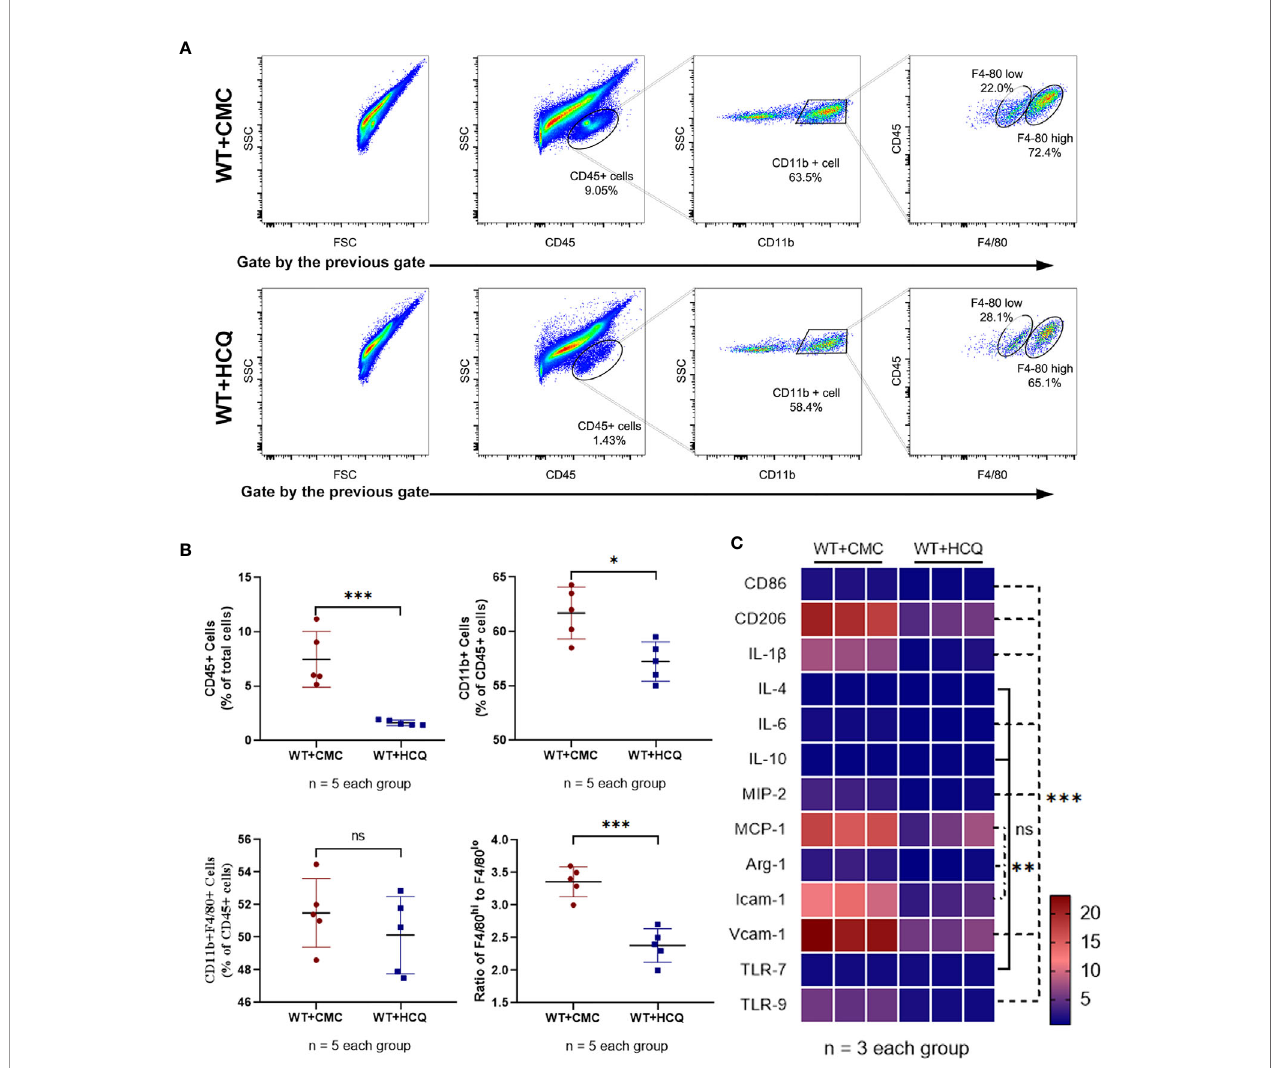
FIGURE 2 | HCQ treatment regulates leukocyte in fi ltration and phenotype of macrophage in the kidney following IRI in vivo . In fl ammatory cell in fi ltration in CMC- treated and HCQ-treated kidneys at day 28 following IRI was determined using fl ow cytometry. (A) Representative dot plots of CD45+ cells and different types of macrophages (CD11b + F4/80 high and CD11b + F4/80 low ). (B) Quanti fi cation of related immune cell in fi ltration, including CD 45+ cells, F4/80 high , and F4/80 low subsets in CD11b+. (C) Heatmap of mRNA expressions related to macrophages in renal tissue at day 28 post IRI. Data are represented as means and analyzed using the Student ’ s t test. NS, no signi fi cant difference, *P < 0.05, **P < 0.01, ***P <